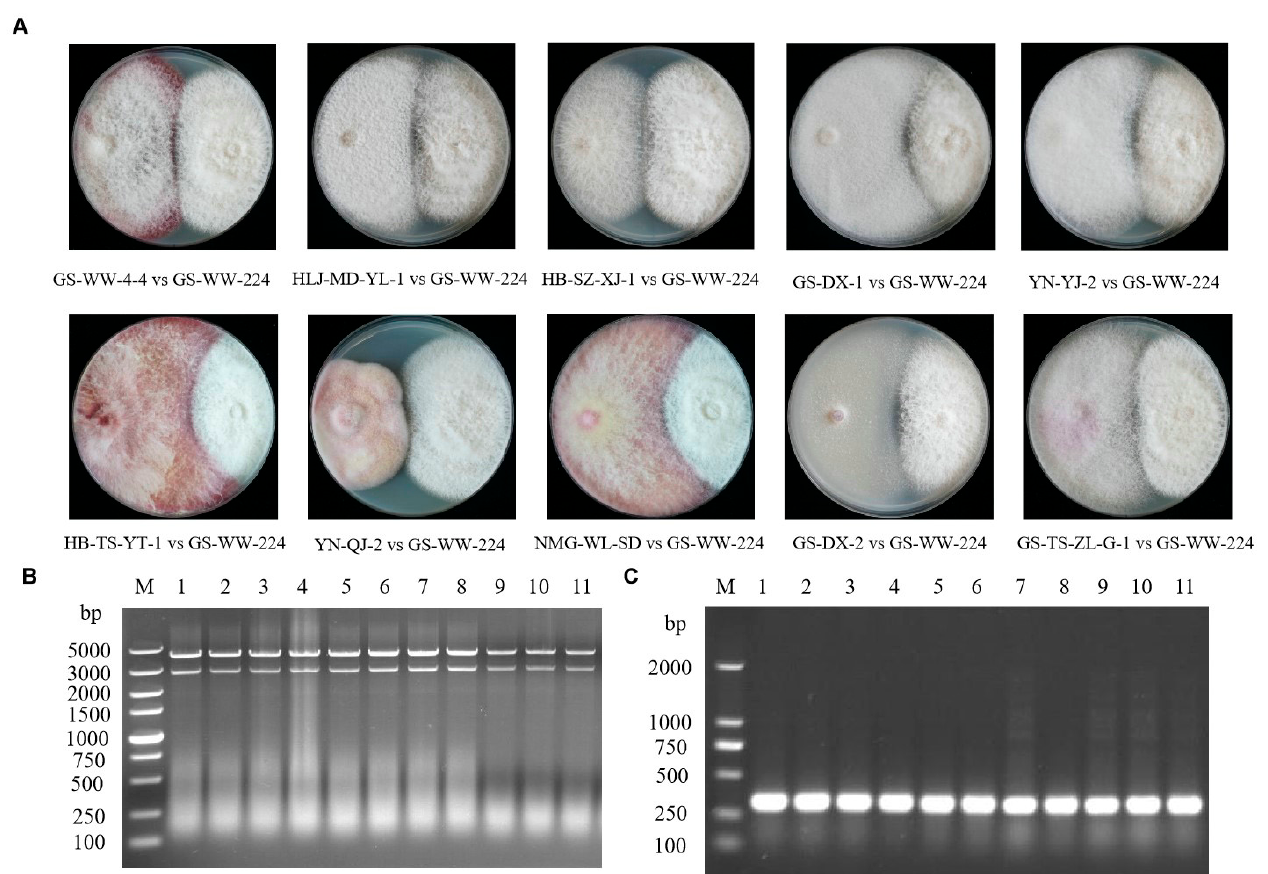
Figure 5. Horizontal transmission of the mycovirus Fusarium avenaceum alternavirus 1 (FaAV1) through hyphal contact in paired (donor-recipient) cultures. ( A ) Colonies formed in paired cultures of Fusarium avenaceum strain GS-WW-224 (donor strain, on the right) and each strain (recipient strain, on the left) obtained from ten other species of Fusarium . ( B ) Confirmation of the presence of FaAV1 in the derivative strains of the ten other species of Fusarium by 1.0% ( w / v ) agarose gel electrophoretic profiles of double-stranded RNA (dsRNA). Lane M: DNA molecular marker DL 5000; lane 1: The dsRNA extracted from F. acuminatum strain GS-WW-4-4; lane 2: The dsRNA extracted from F. brachygibbosum strain HLJ-MD-YL-1; lane 3: The dsRNA extracted from F. equiseti strain HB-SZ-XJ-1; lane 4: The dsRNA extracted from F. flocciferum strain GS-DX-1; lane 5: The dsRNA extracted from F. graminearum strain YN-YJ-2; lane 6: The dsRNA extracted from F. oxysporum strain HB-TS-YT-1; lane 7: The dsRNA extracted from F. proliferatum strain YN-QJ-2; lane 8: The dsRNA extracted from F. redolens strain NMG-WL-SD; lane 9: The dsRNA extracted from F. sambucinum strain GS-DX-2; lane 10: The dsRNA extracted from F. solani strain GS-TS-ZL-G-1; lane 11: The dsRNA extracted F. avenaceum strain GS-WW-224. ( C ) Confirmation of the presence of FaAV1 in the derivative strains of the ten other species of Fusarium by reverse transcription-polymerase chain reaction (RT-PCR) analysis of dsRNA using FaAV1-specific primers (dsRNA2-gap-1F and dsRNA2-gap-1R) in 1.0% ( w / v ) agarose gel electrophoresis. Lane M: DNA molecular marker DL 2000; lane 1: Products of RT-PCR from F. acuminatum strain GS-WW-4-4; lane 2: Products of RT-PCR from F. brachygibbosum strain HLJ-MD-YL-1; lane 3: Products of RT-PCR from F. equiseti strain HB-SZ-XJ-1; lane 4: Products of RT-PCR from F. flocciferum strain GS-DX-1; lane 5: Products of RT-PCR from F. graminearum strain YN-YJ-2; lane 6: Products of RT-PCR from F. oxysporum strain HB-TS-YT-1; lane 7: Products of RT-PCR from F. proliferatum strain YN-QJ-2; lane 8: Products of RT-PCR from F. redolens strain NMG-WL-SD; lane 9: Products of RT-PCR from F. sambucinum strain GS-DX-2; lane 10: Products of RT-PCR from F. solani strain GS-TS-ZL-G-1; lane 11: Products of RT-PCR from F. avenaceum strain GS-WW-224.